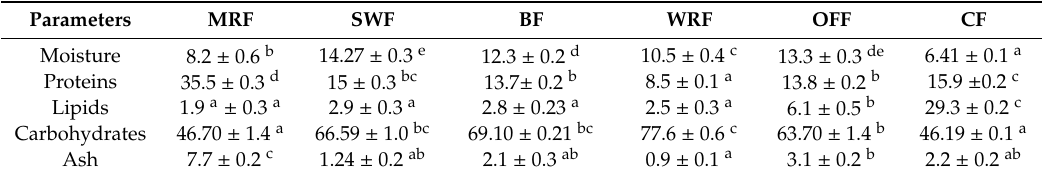
Table 1. Proximate composition of spent malt rootlets (MRF), whole wheat spelt flour (SWF), buckwheat flour (BF), whole rice flour (WRF), oat flakes flour (OFF), and chia seeds flour (CF) used as raw materials in enriched biscuits